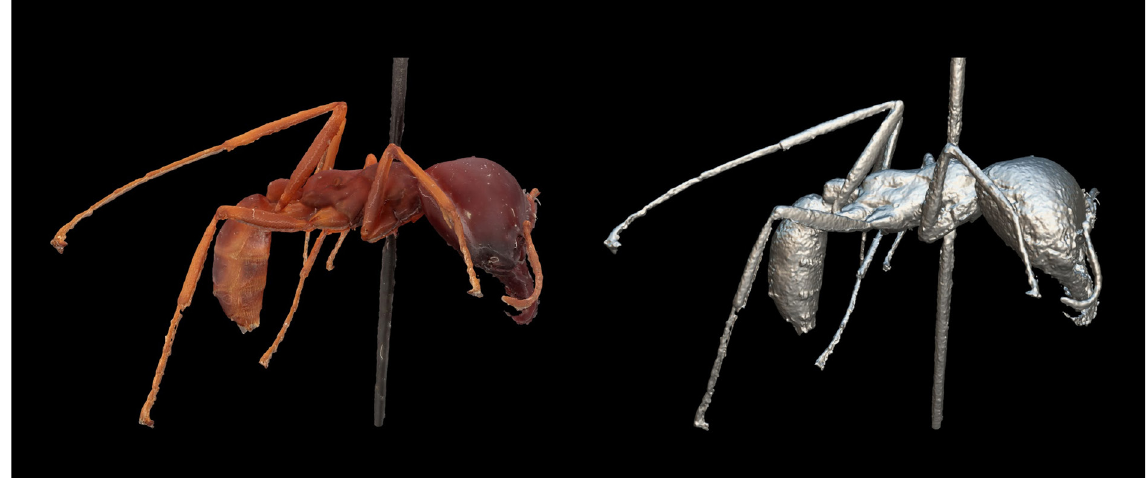
Fig. 3.19. 3D model of a Dorylus ant (size: 1.5 cm) based upon focus stacked images, textured model is on the left, the view of only the mesh is on the right.